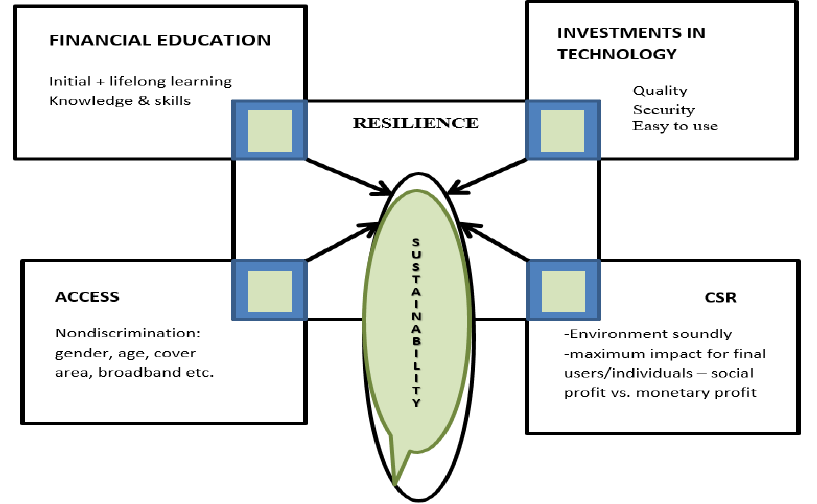
Figure 12. Sustainable digital financial inclusion proposed model for post-pandemic period. Source: Authors’ contribution based on research results.